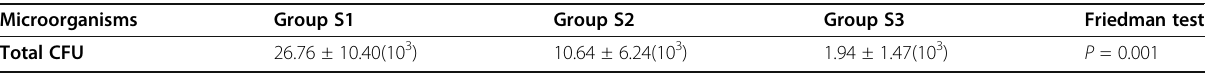
Table 3 Comparison of the mean colony forming units of total microorganisms among the three groups